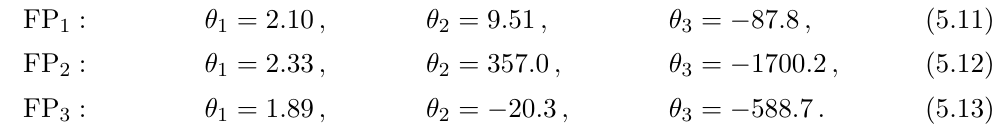
Figure 5 . The behavior of the beta function of D as a function of D . For the other couplings we use the values at the R-fixed point in eq. (2.42). The blue point is just its fixed point value of D ∗ . For these fixed points the critical exponents are found